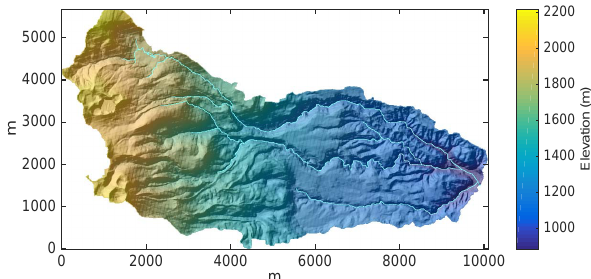
Figure 18. Topography and stream networks in SNK catchment.